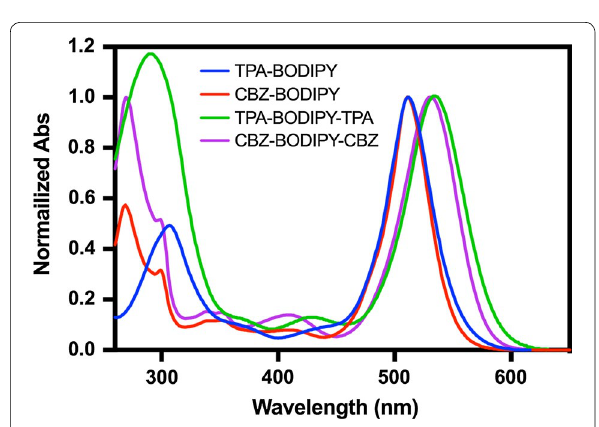
Table 1 Photophysical and electrochemical properties of BODIPY dyads and triads Compounds λ max